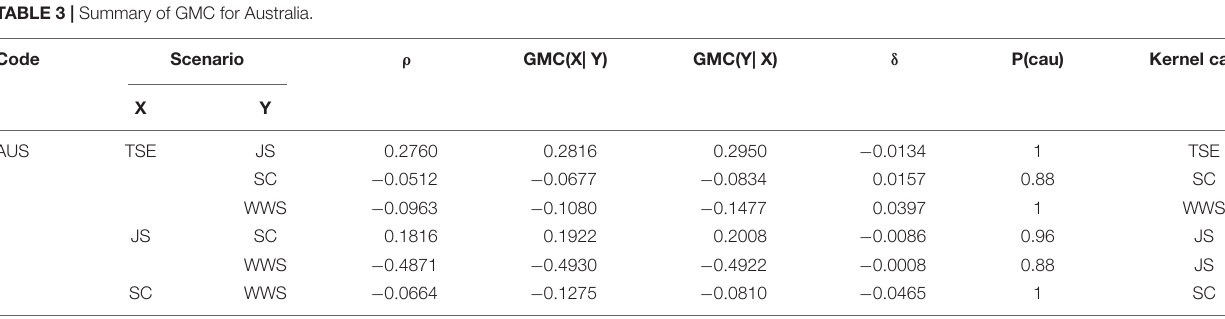
FIGURE 5 | Histogram plots of latent traits (LTs) measured workplace well-being and stress (WWS). TABLE 3 | Summary of GMC for